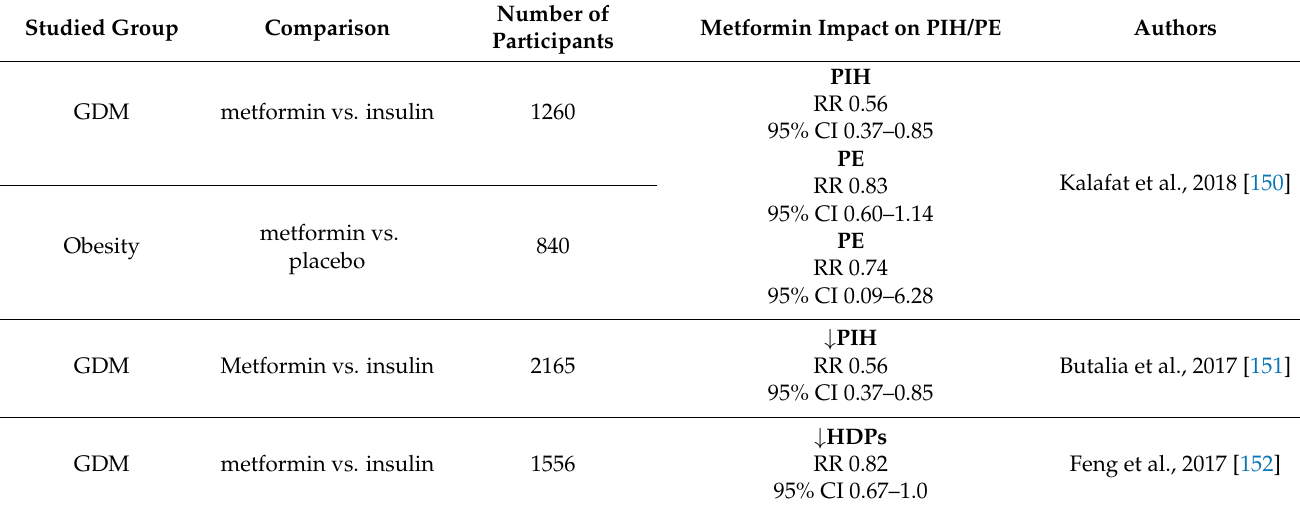
Table 2. Selected meta-analyses on metformin influence on PE and PIH